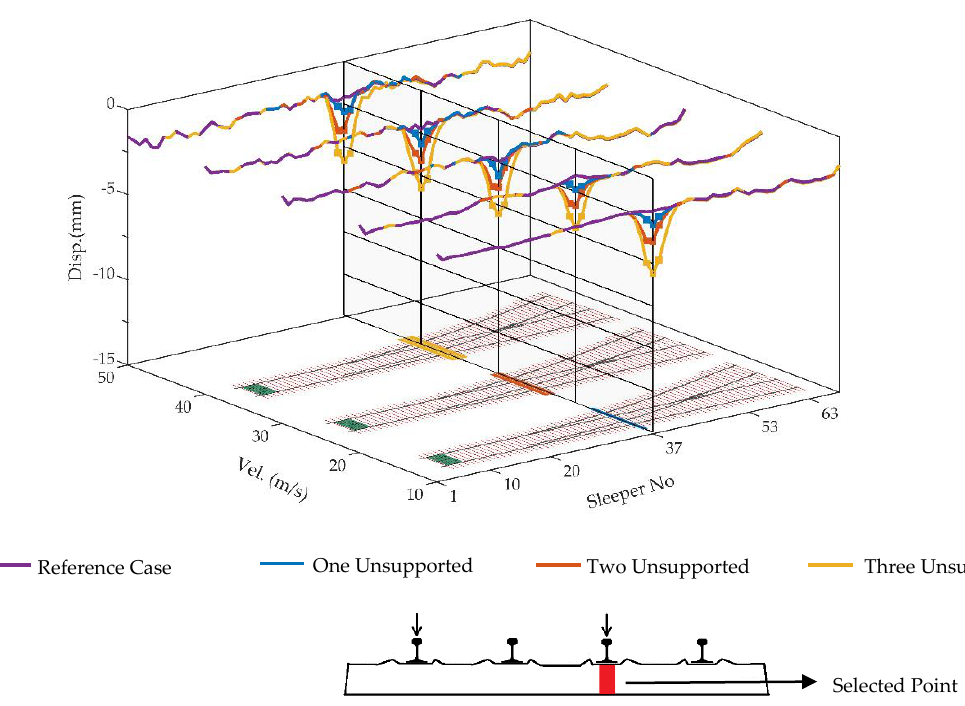
Figure 6. The maximum displacement of bearers at rail seats when an unsupported bearer exists at closure panel.